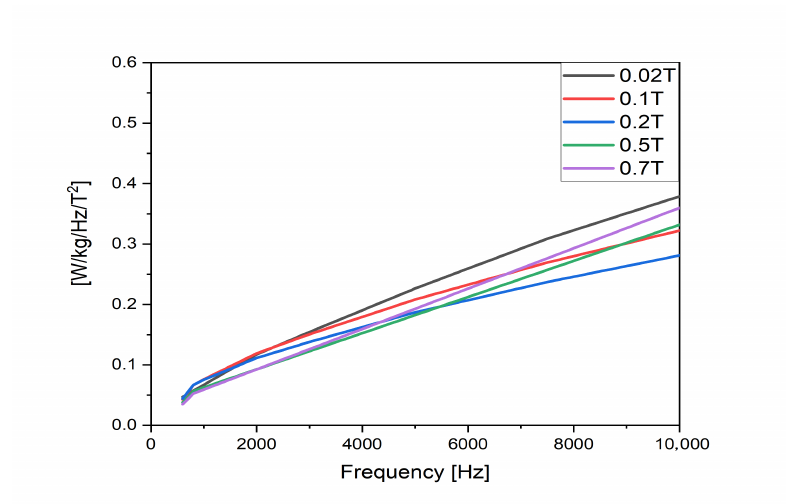
Figure 7. Iron loss density per frequency and flux density according to the frequency (30PNF1600).